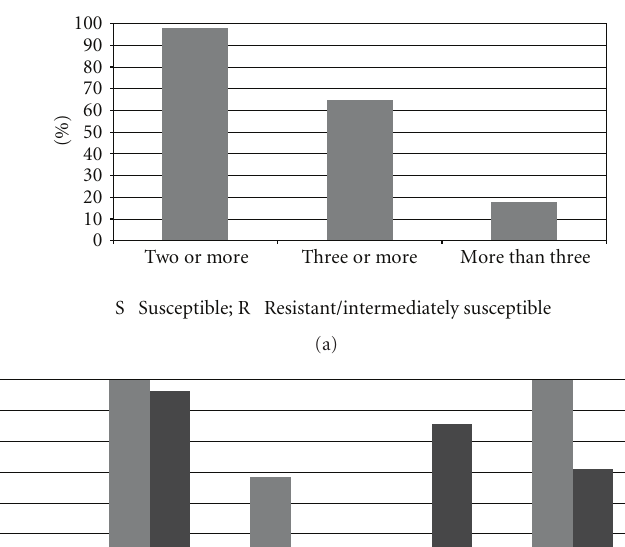
Figure 1: Prevalence of resistance, intermediate susceptibility, and susceptibility towards the antibacterial drugs tested among 134 Gram negative bacterial strains isolated from foods, food contact surfaces, and utensils.